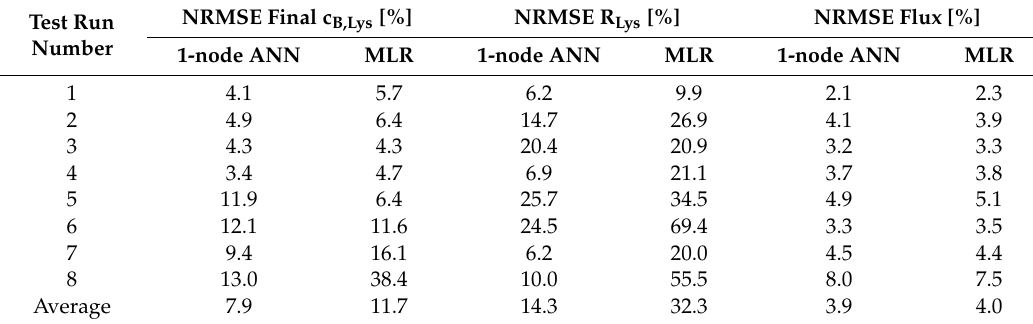
Table A5 summarized the mass transfer coe ffi cient k and gel concentration c G for flux prediction using the SFM. The SFM can be set up for a one-component solution only and since the BSA concentration was 4 to 46 times higher than the lysozyme concentration, BSA was chosen as the modeled component. k and c G for BSA were calculated for a BSA one-component solution (Table A5 left) and two-component solution (Table A5 right) containing BSA with lysozyme. k from two-component solution was generally lower than for